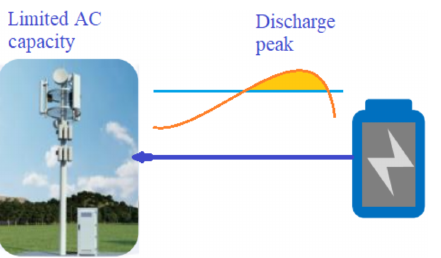
Figure 1. LIB and smart power can reduce approximately 90% of AC Mains Modernization